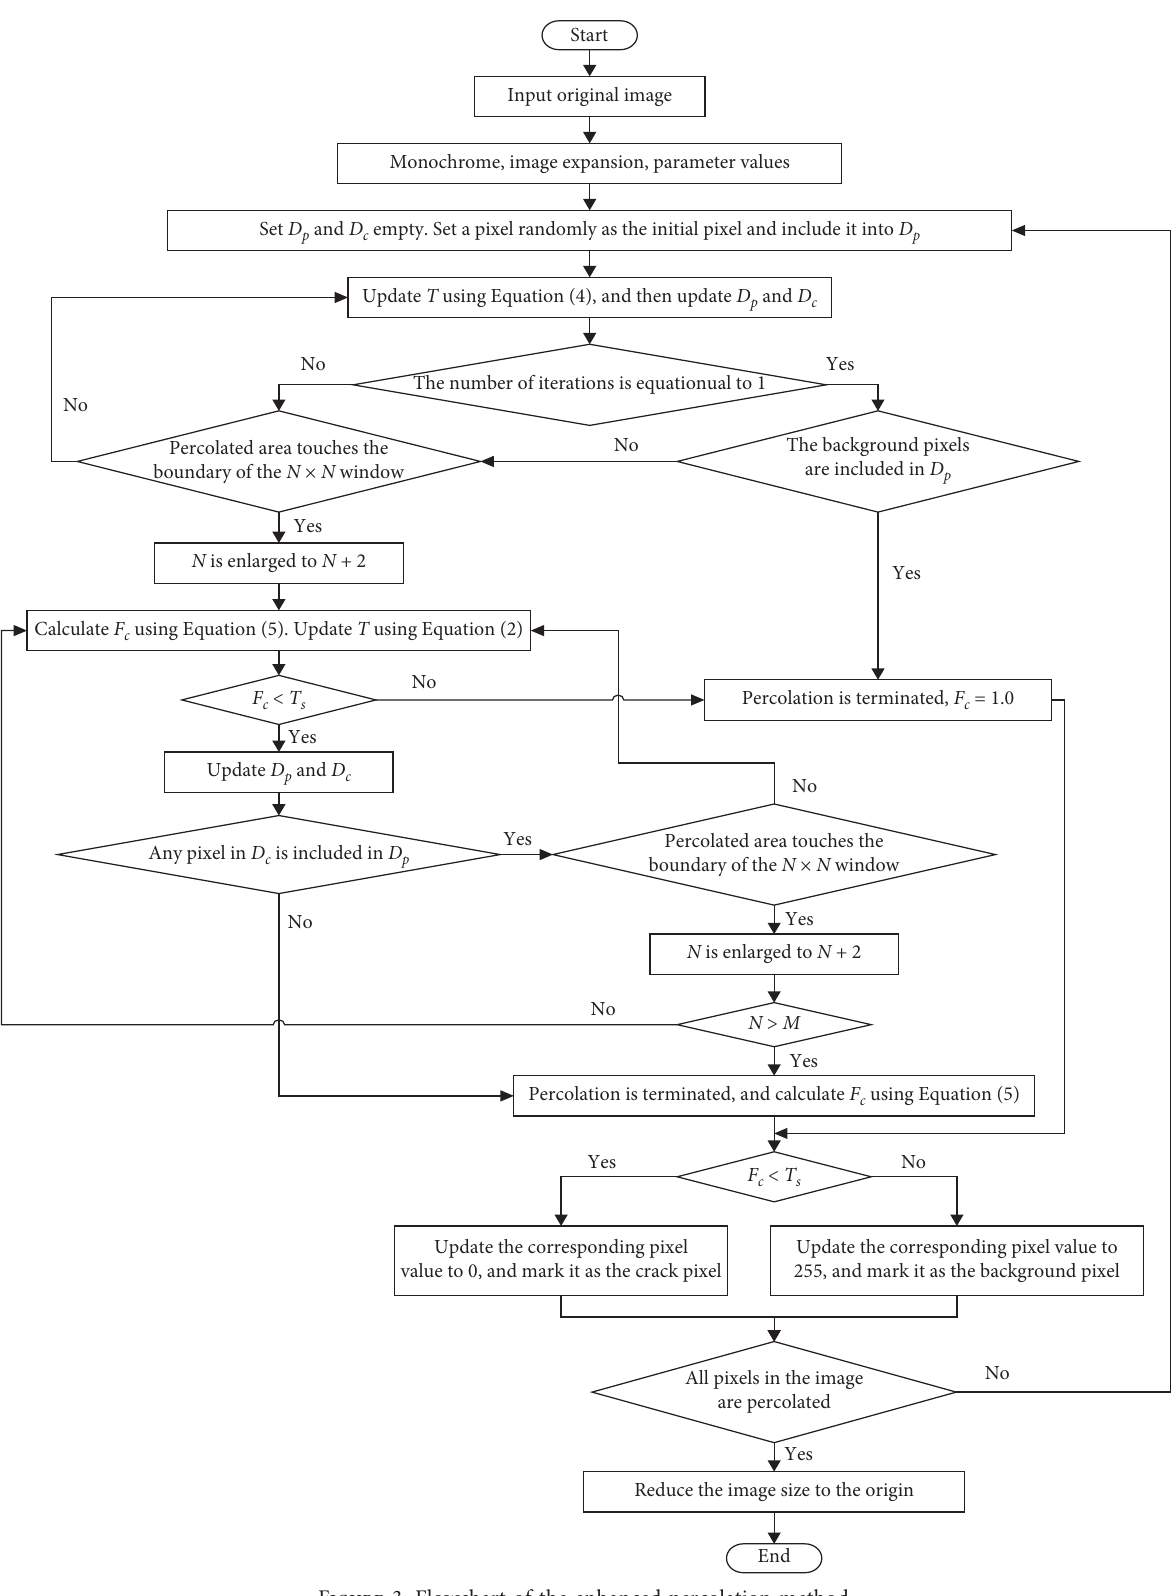
Figure 3: Flowchart of the enhanced percolation